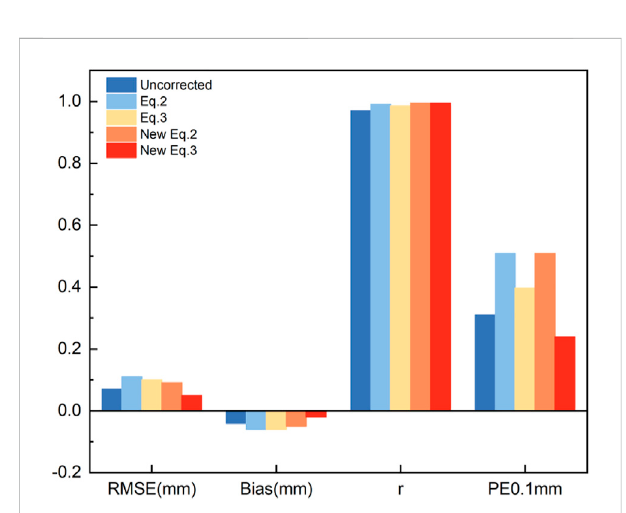
FIGURE 5 RMSE, mean bias, r, and PE 0.1mm valuesof snowfall for Geonor T- 200B Eqs 2, 3 were the results calculated by original parameters from Kochendorfer et al. (2017a), and new Eqs 2, 3 were the results calculatedbythelocaldatasetsusingthetenfoldcross-validation